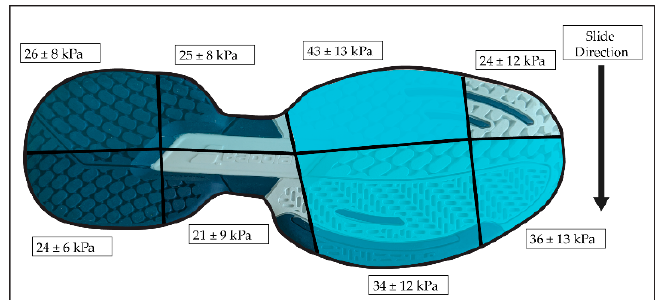
Figure 1. A mean pressure insole map from a leading foot during a hardcourt slide